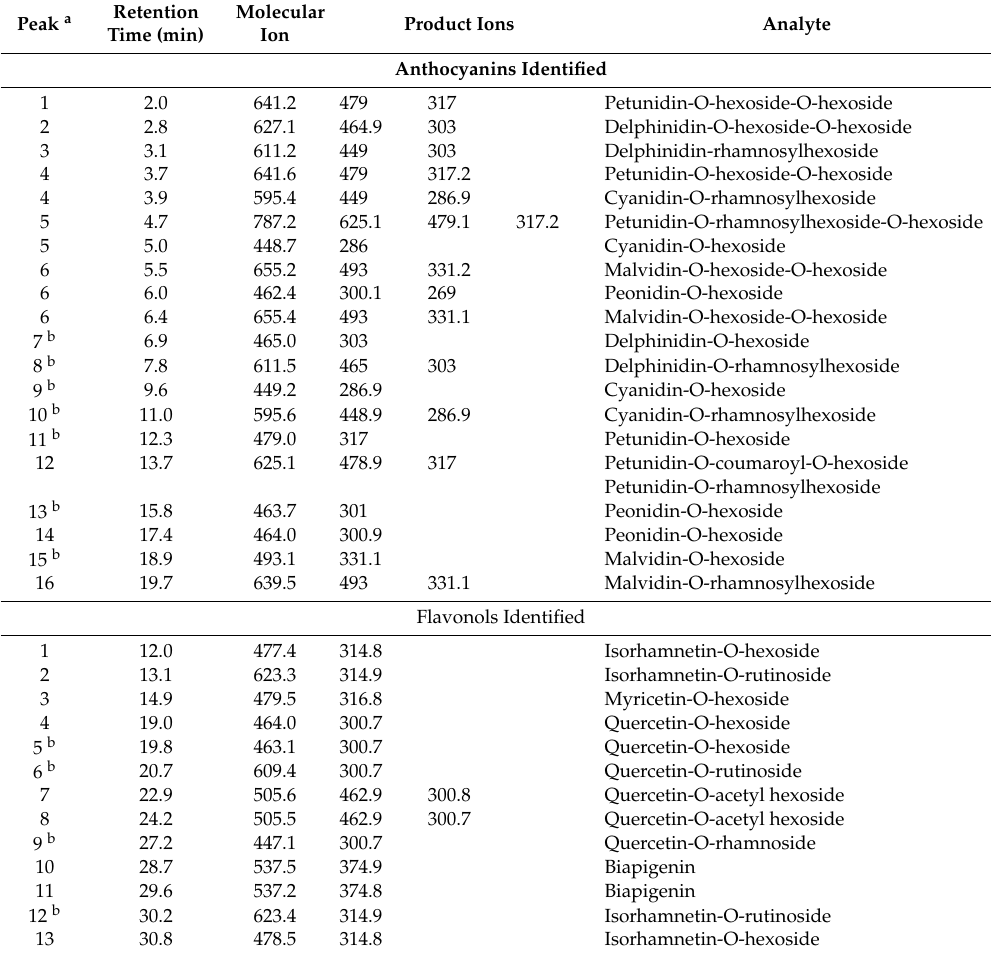
Table 1. Anthocyanins and flavonols identified in the hydroalcoholic Calafate extract following LC-MS